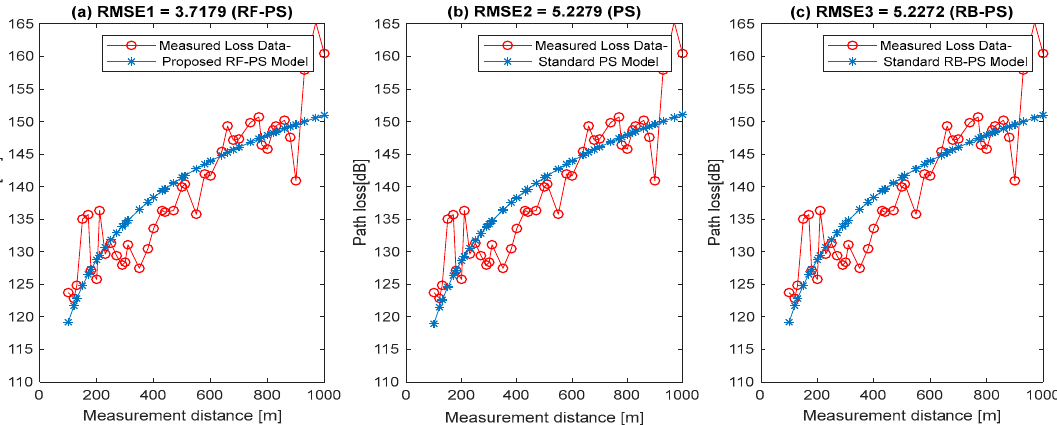
Figure 16. Results showing the measured path loss versus distance using the hybrid RF-PS method and two existing standard path loss prediction methods in site 3 of location 3.